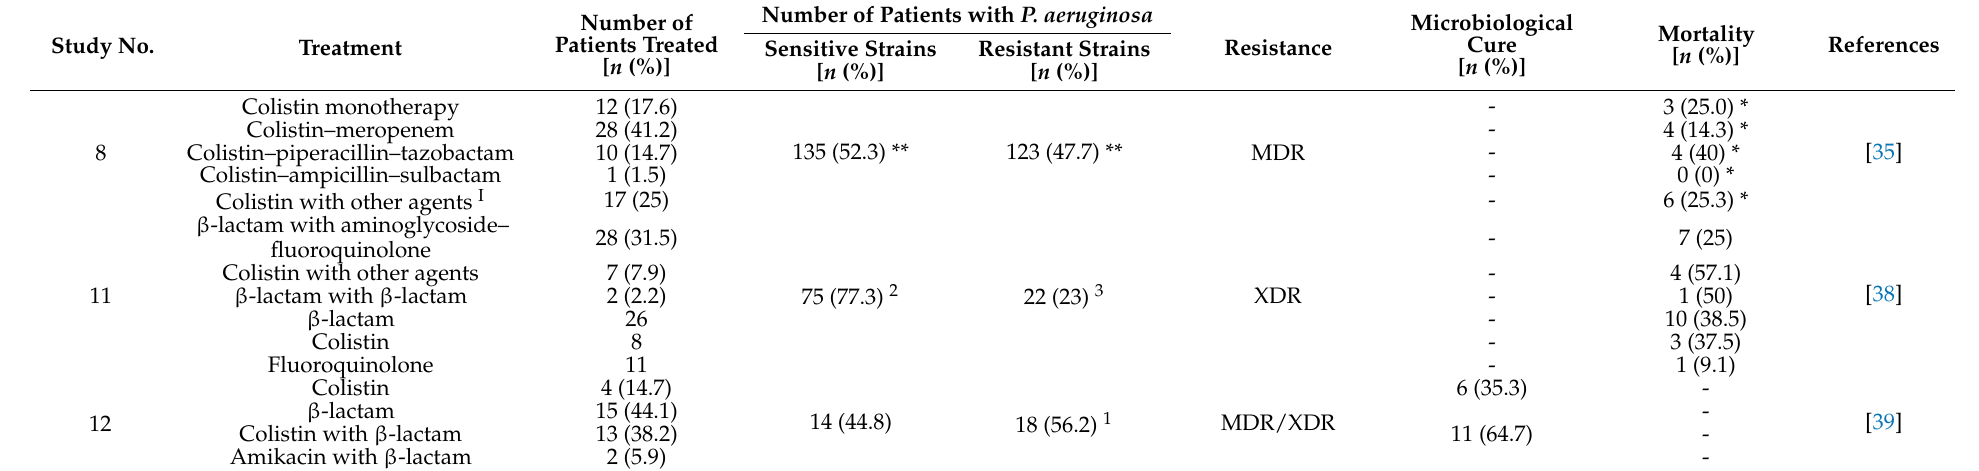
Table 4. Study findings with unclear distribution of resistant and susceptible